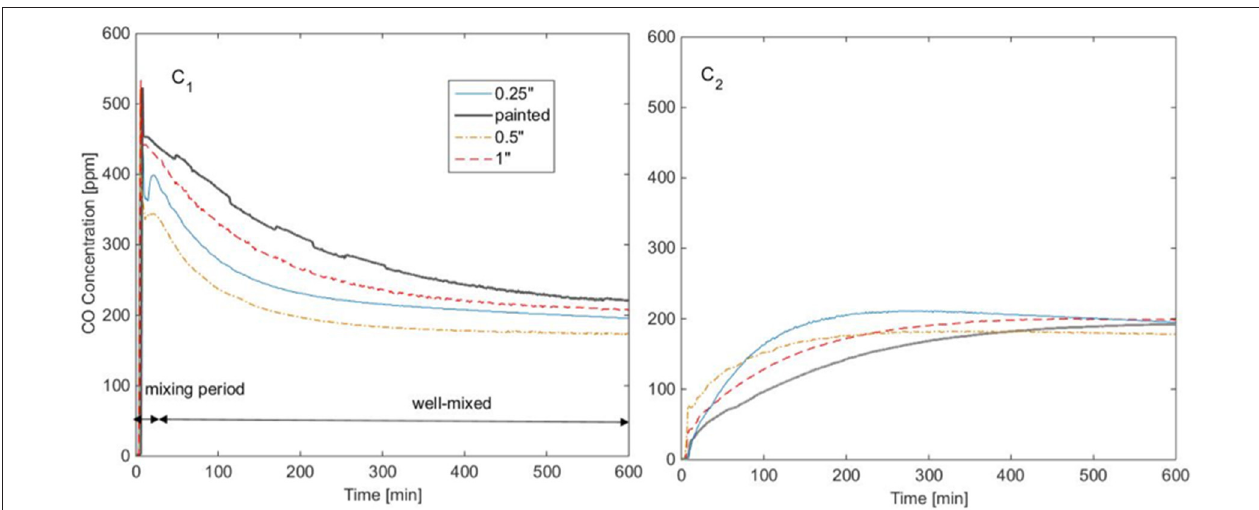
FIGURE 2 | Summary of the experiments in Hampson et al. (2013); left: CO concentration in the infusion chamber, right: CO concentration in the control chamber.